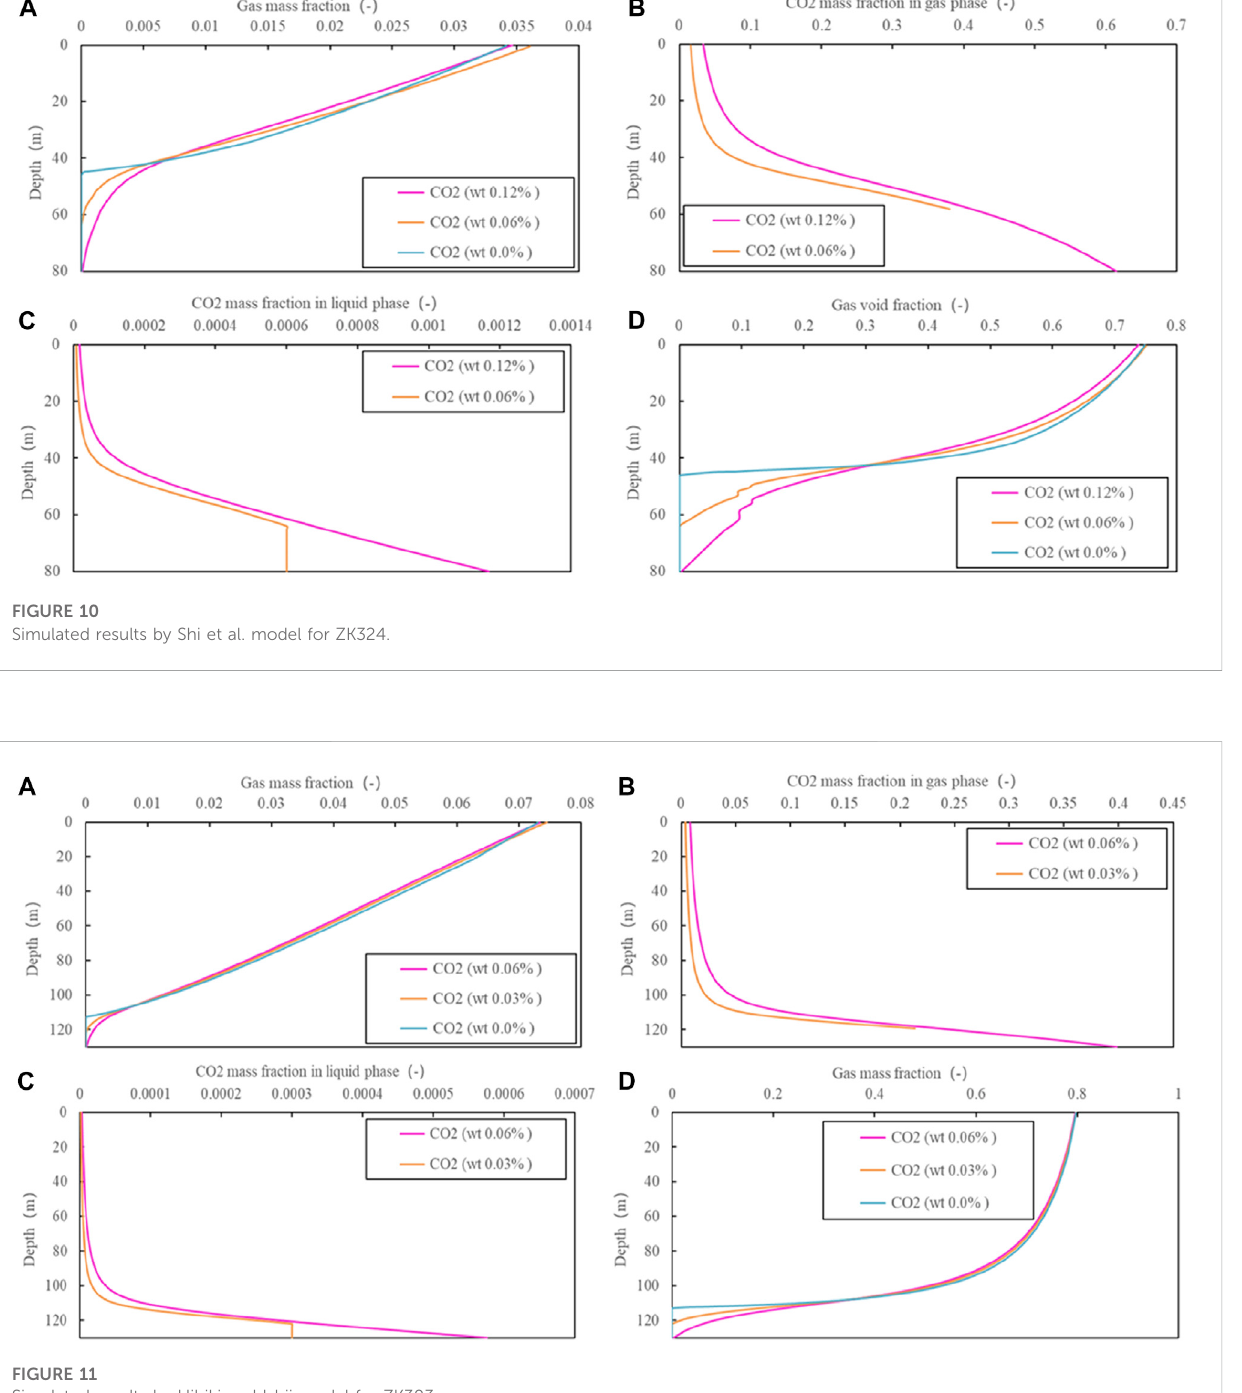
between the measurement and calculation with the homogeneous model for ZK324. The calculation from the Shi et al. model is the closest to the measurement results, with average errors for pressure and temperature of respectively 3.58% and 0.79% (Table 3). The CO 2 content has a certain effect on the pressure and temperature